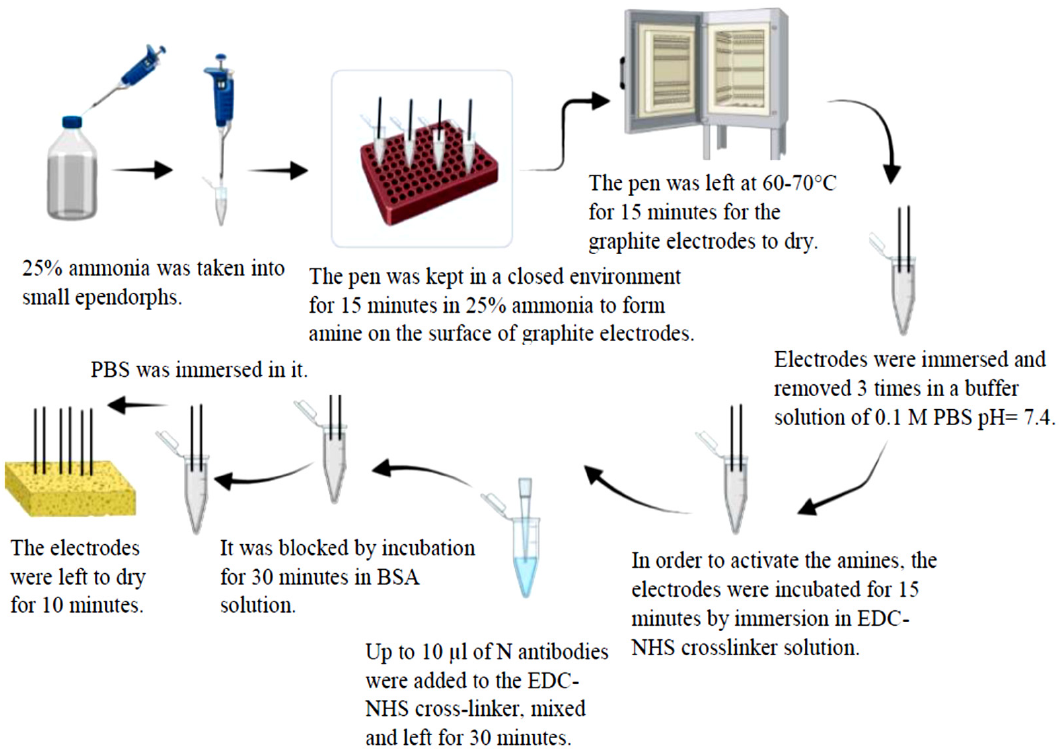
Figure 1. Steps of functionalization of pencil graphite electrodes modified with hydroxyapatite and copper oxide with COVID-19 nucleocapsid antibody.